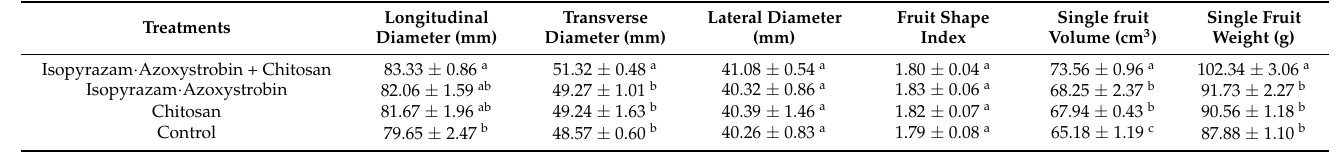
Table 3. The effects of isopyrazam · azoxystrobin and chitosan on the growth of kiwifruit fruits. Treatments